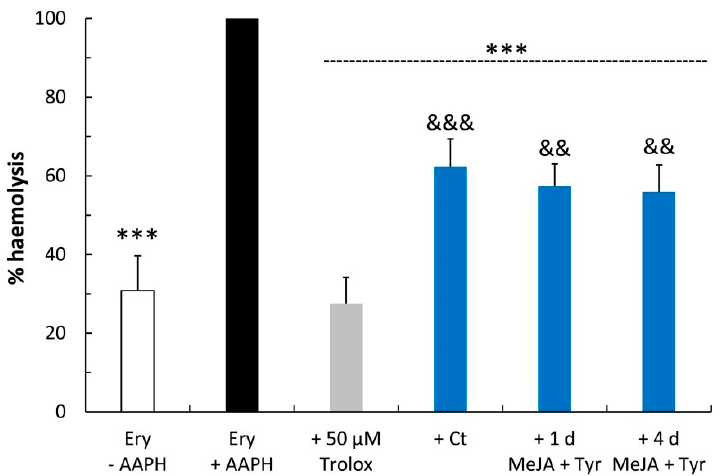
Figure 7. Anti-hemolytic activity of hemp cell extracts (12.5 µ g / mL). Trolox was used as a reference standard. Values represent the mean ± SD of three measurements. Ery-AAPH: negative control without AAPH; Ery + AAPH: positive control with AAPH; Ct: control cell extracts; 1 d: 1 day; 4 d: 4 days; MeJA: methyl jasmonate; Tyr: tyrosine. One-way ANOVA with Bonferroni’s post hoc test was applied: * indicates significance versus Ery + AAPH (*** p ≤ 0.001); # indicates significance versus the Ct sample ( ## p ≤ 0.01; ### p ≤ 0.001); and & indicates significance versus 50 µ M Trolox ( && p ≤ 0.01; &&& p ≤ 0.001).